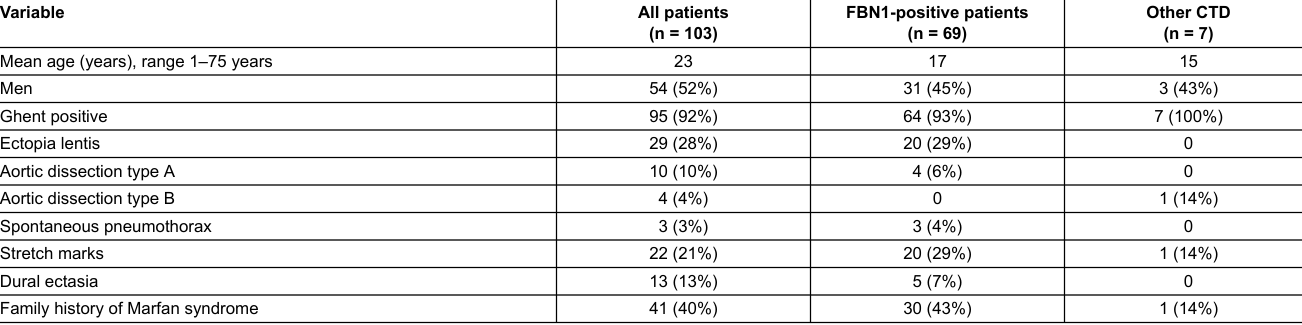
Table 2: Background of all patients and separate analysis of participants who underwent genetic analysis. Variable